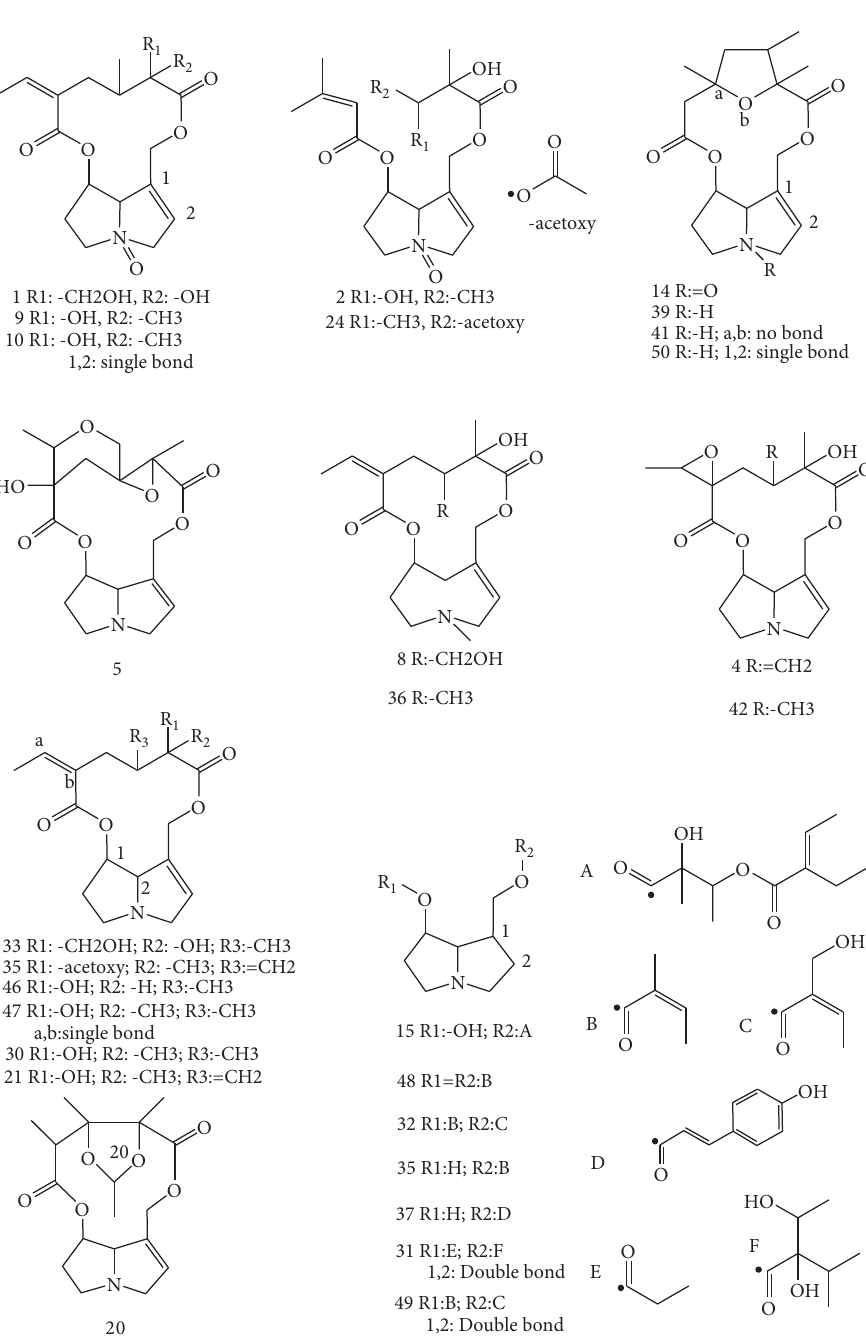
Figure 3: Structure of PAs that have been identified in five Senecio